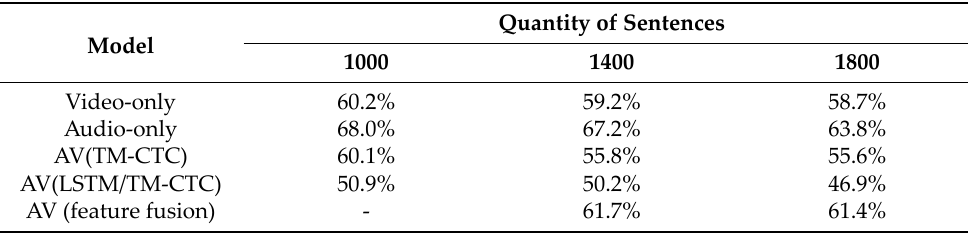
Table 5. CER for different quantities of sentences in video‑only, audio‑only, and different fusion models.